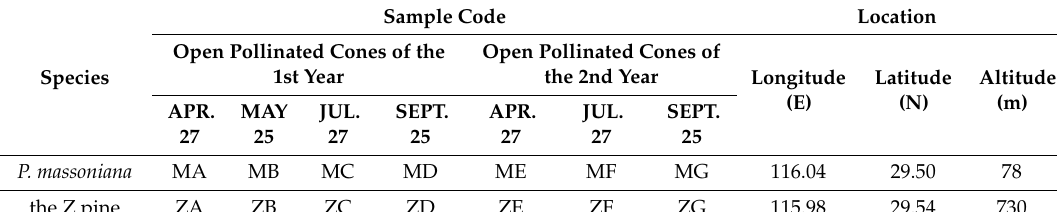
Species Table 1. Information on the geographical sites of sample collection of P. massoniana and the Z pine.